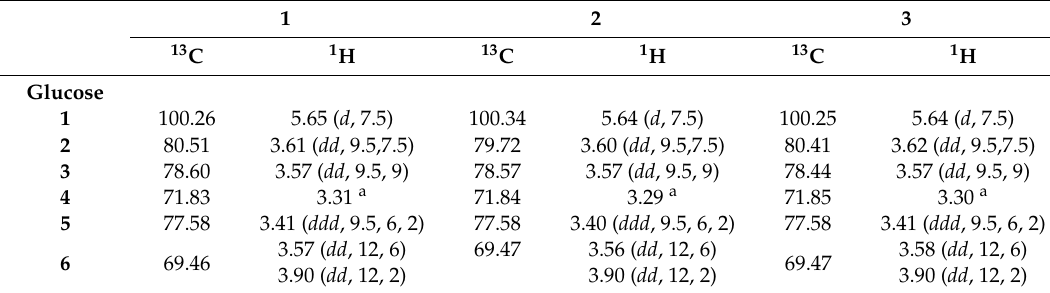
Table 2. 13 C and 1 H-NMR data ( J in Hz) for the sugar units of kaempferol glycosides 1 , 2 and 3 in CD 3 OD.